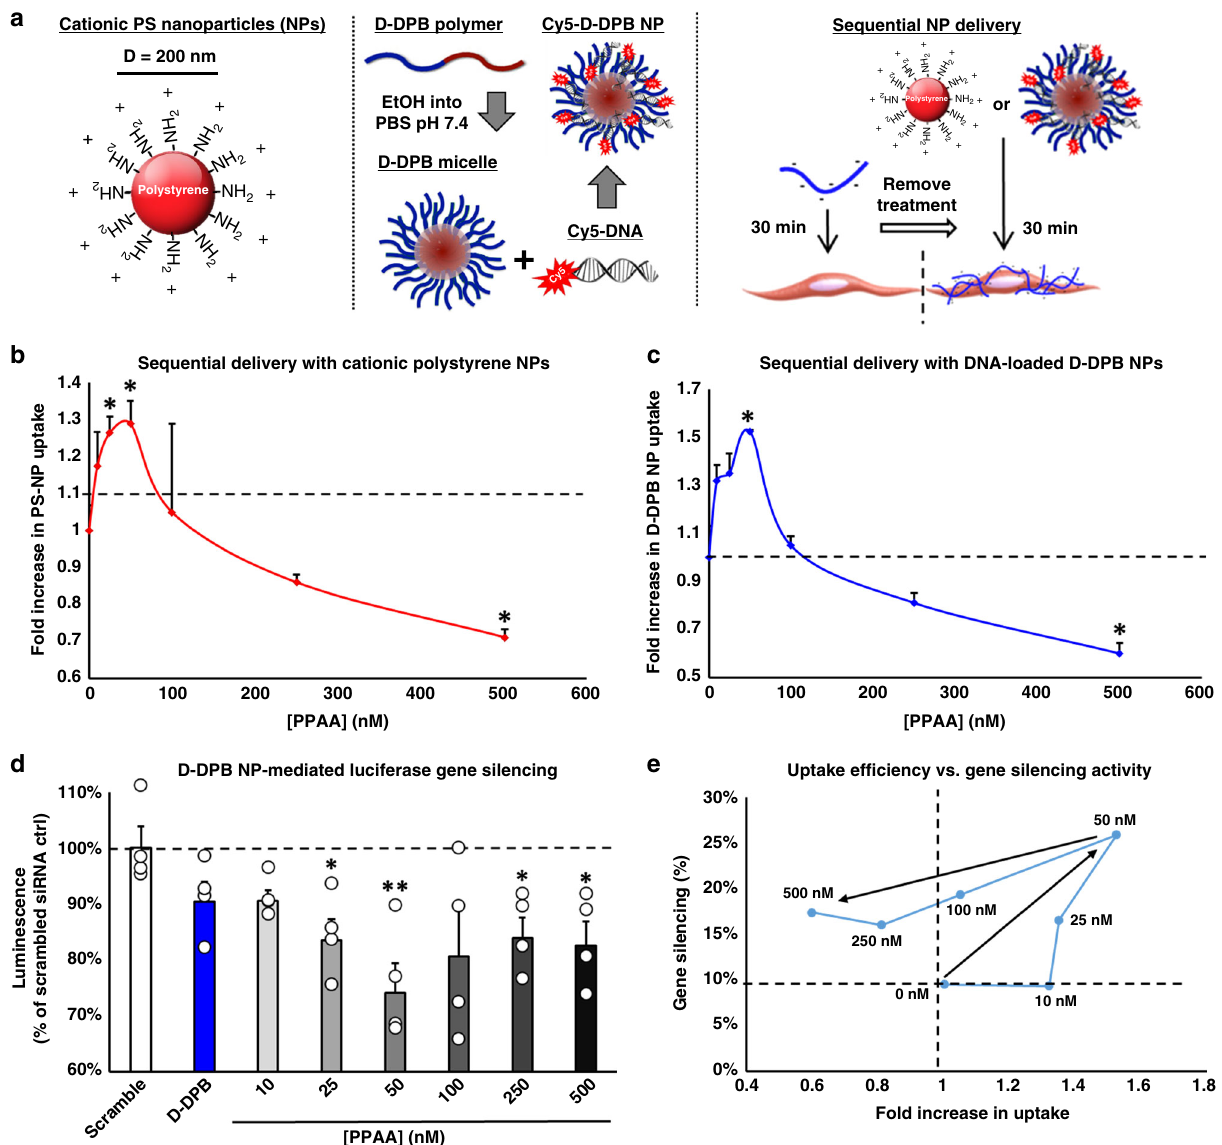
Fig. 6 PPAA pretreatment enhances cationic nanoparticle uptake and bioactivity. a Schematic representation of cationic, amine-surface modi fi ed 200 nm polystyrene nanoparticles, synthesis of Cy5-labeled DNA-loaded D-DPB polymeric micellar nanoparticles, and sequential delivery of these nanoparticle formulations following PPAA pretreatment. The effects of dose-dependent PPAA pretreatment on the uptake of b cationic polysterene nanoparticles and c Cy5-labeled DNA-loaded D-DPB nanoparticles in A7r5 cells; * p < 0.05, vs. treatment with nanoparticles alone (i.e., 0 nM PPAA). d The effects of dose- dependent PPAA pretreatment on luciferase gene silencing in luciferase expressing A7r5s; * p < 0.05, ** p < 0.01, vs. D-DPB nanoparticles loaded